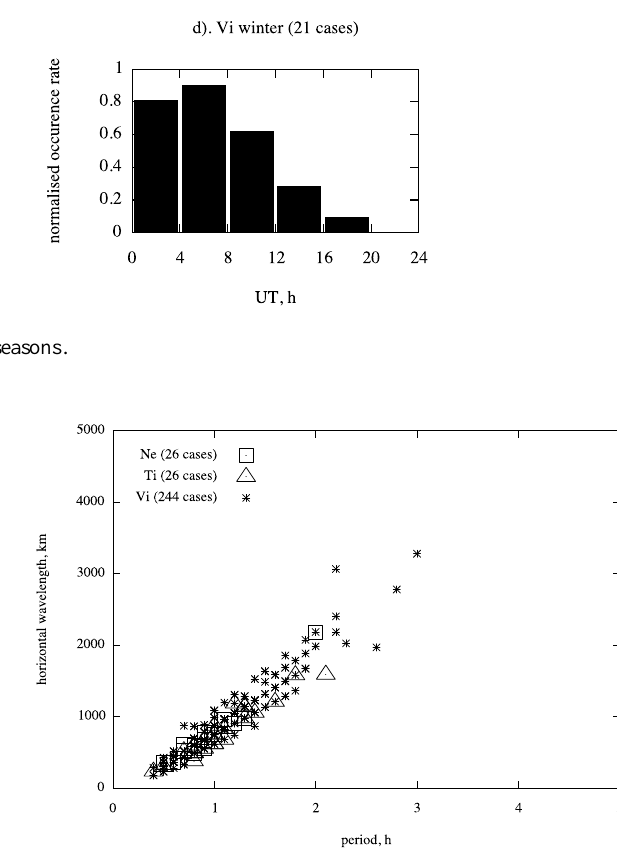
Fig. 15. Dependency of the estimated horizontal wavelength on the oscillation period as based on the AGW dispersion relation by Hines